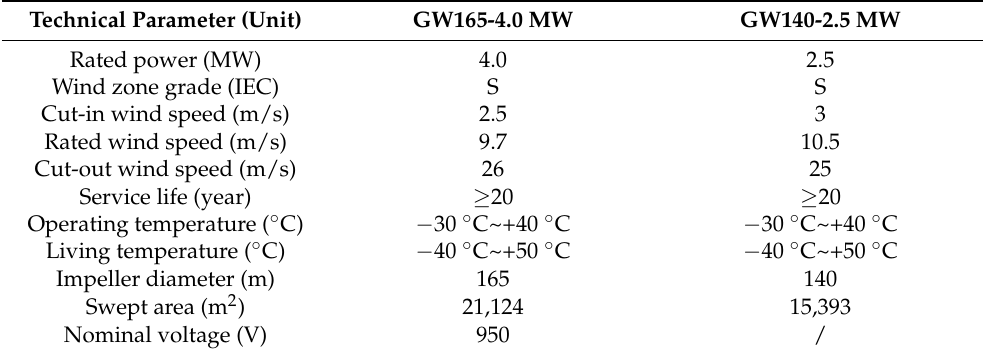
Table 3. The technical parameter of two kinds of turbine